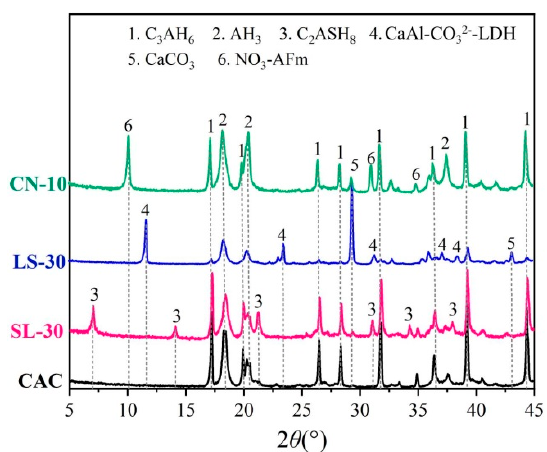
Table 5. Mix proportion of the pastes used for the mortar-reinforcement specimen (wt.%).